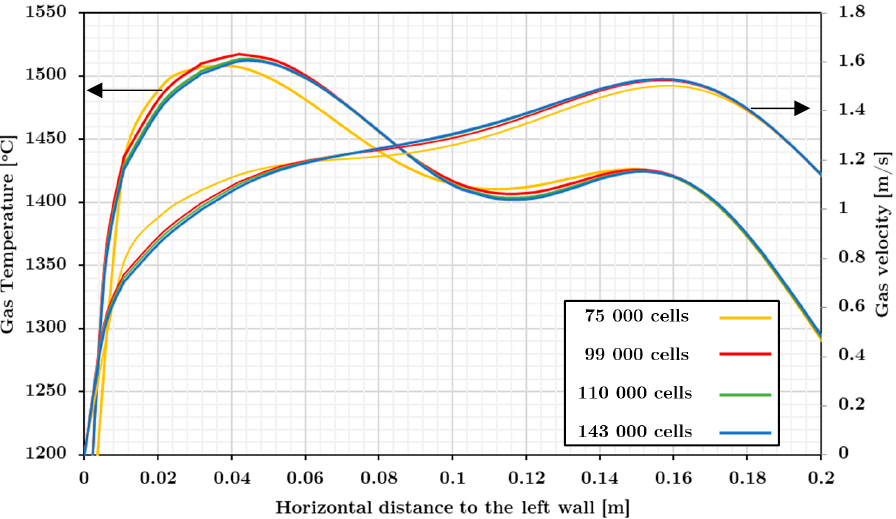
Figure 3. Confirmation of mesh independent CFD results (profiles defined along a sampling line at y = 0.8 m and x = 0 to 0.2 m).